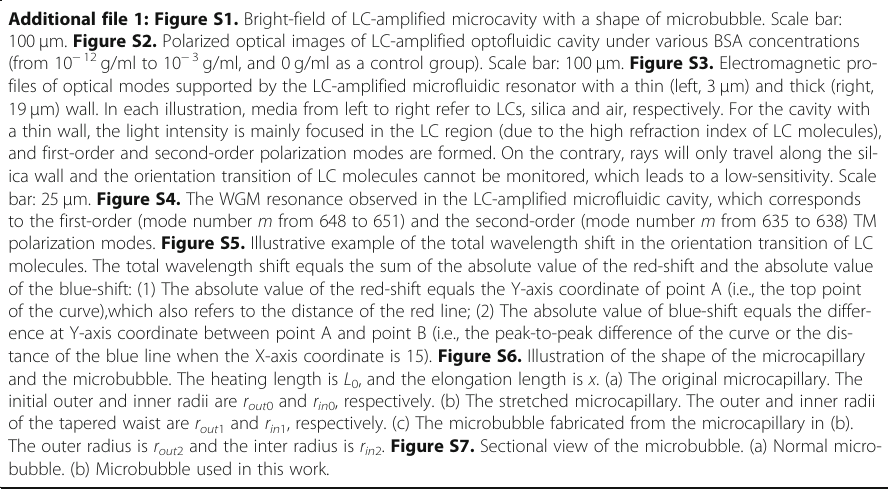
Supplementary Information The online version contains supplementary material available at https://doi.org/10.1186/s43074-021-00041-1. Additional file 1: Figure S1. Bright-field of LC-amplified microcavity with a shape of microbubble. Scale bar: 100 μ m. Figure S2. Polarized optical images of LC-amplified optofluidic cavity under various BSA concentrations (from 10 − 12 g/ml to 10 − 3 g/ml, and 0 g/ml as a control group). Scale bar: 100 μ m. Figure S3. Electromagnetic pro- files of optical modes supported by the LC-amplified microfluidic resonator with a thin (left, 3 μ m) and thick (right, 19 μ m) wall. In each illustration, media from left to right refer to LCs, silica and air, respectively. For the cavity with a thin wall, the light intensity is mainly focused in the LC region (due to the high refraction index of LC molecules), and first-order and second-order polarization modes are formed. On the contrary, rays will only travel along the sil- ica wall and the orientation transition of LC molecules cannot be monitored, which leads to a low-sensitivity. Scale bar: 25 μ m. Figure S4. The WGM resonance observed in the LC-amplified microfluidic cavity, which corresponds to the first-order (mode number m from 648 to 651) and the second-order (mode number m from 635 to 638) TM polarization modes. Figure S5. Illustrative example of the total wavelength shift in the orientation transition of LC molecules. The total wavelength shift equals the sum of the absolute value of the red-shift and the absolute value of the blue-shift: (1) The absolute value of the red-shift equals the Y-axis coordinate of point A (i.e., the top point of the curve),which also refers to the distance of the red line; (2) The absolute value of blue-shift equals the differ- ence at Y-axis coordinate between point A and point B (i.e., the peak-to-peak difference of the curve or the dis- tance of the blue line when the X-axis coordinate is 15). Figure S6. Illustration of the shape of the microcapillary and the microbubble. The heating length is L 0 , and the elongation length is x . (a) The original microcapillary. The initial outer and inner radii are r out 0 and r in 0 , respectively. (b) The stretched microcapillary. The outer and inner radii of the tapered waist are r out 1 and r in 1 , respectively. (c) The microbubble fabricated from the microcapillary in (b). The outer radius is r out 2 and the inter radius is r in 2 . Figure S7. Sectional view of the microbubble. (a) Normal micro- bubble. (b) Microbubble used in this